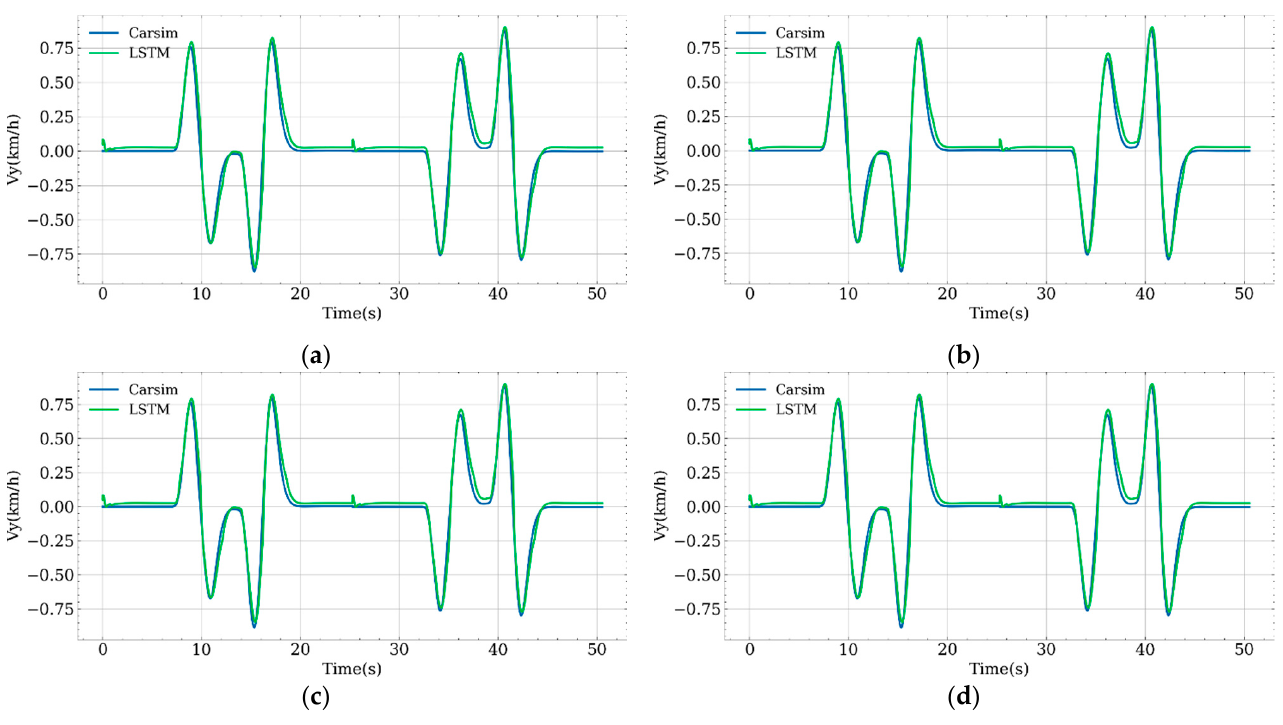
Figure 6. Estimation Results under 30 km/h DLC condition: ( a ) road friction coefficient of 0.3; ( b ) road friction coefficient of 0.5; ( c ) road friction coefficient of 0.85; ( d ) road friction coefficient of 1.0.